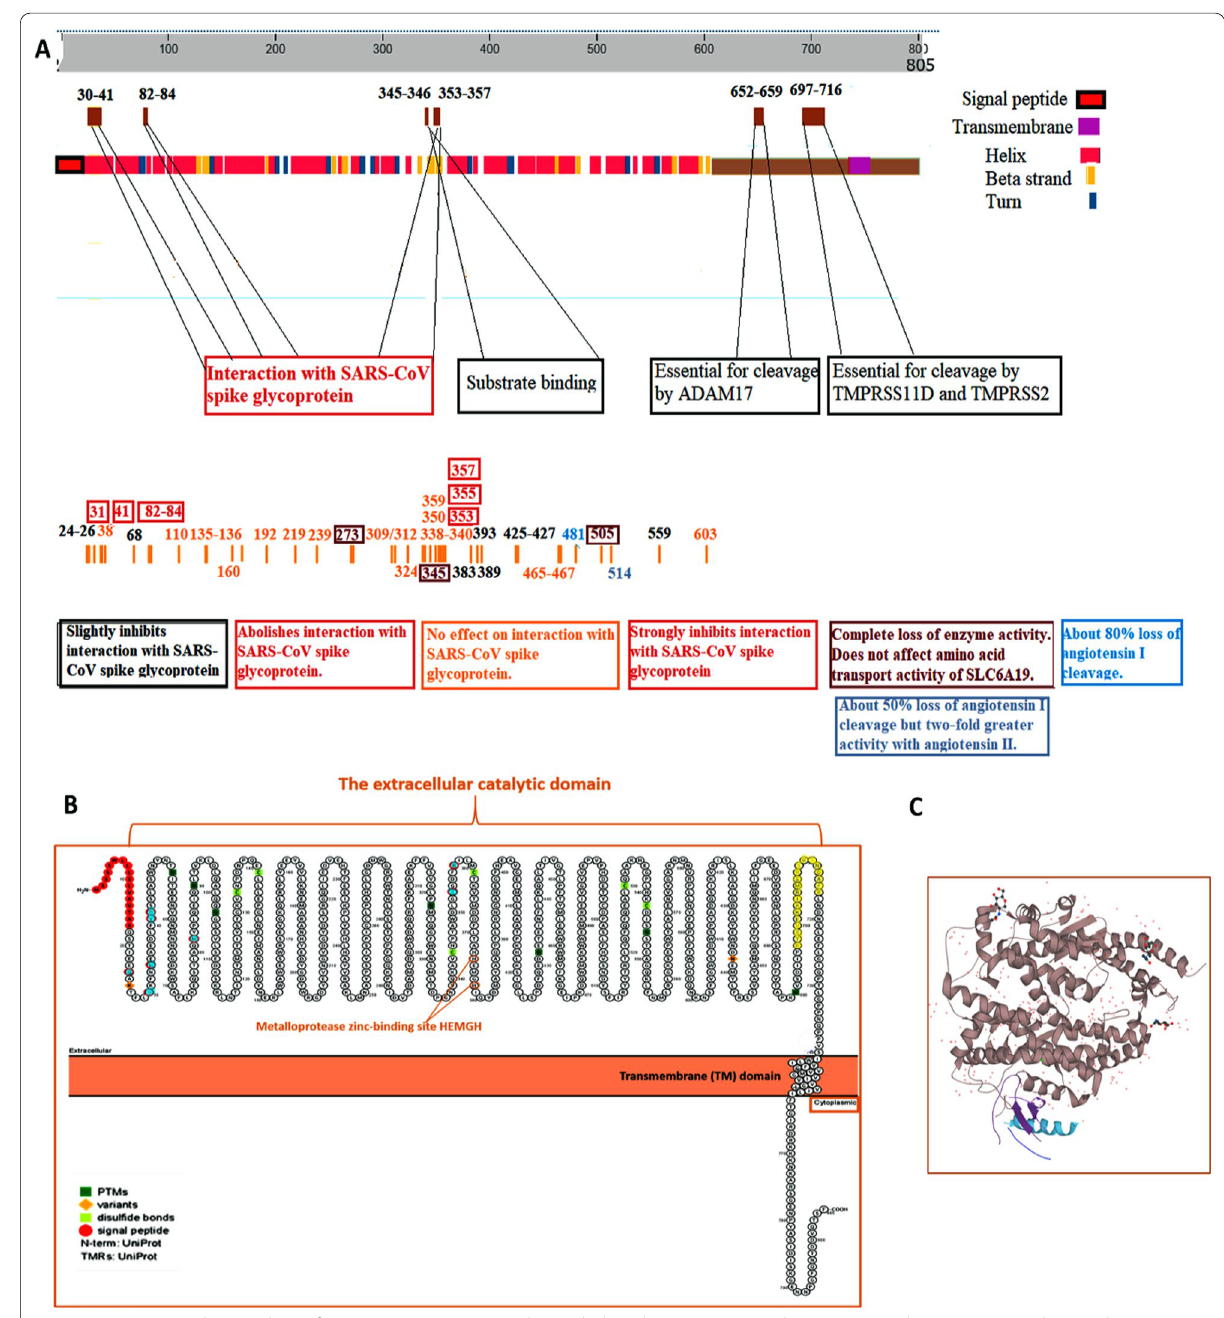
Fig. 3 Sequence and aa residues of ACE2. A ACE2 gene encoding a deduced 805-aa protein. The unprocessed ACE2 (1–17) and ACE2 chain (18–805). Functional roles are illustrated based on [34] and [35]. (https:// www. unipr ot. org/ unipr ot/ Q9BYF1/ protv ista). B ACE2 sequence contains an N-terminal signal (1 to 18), a TM domain (740 to 763), and a metalloprotease zinc-binding consensus (374 to 378, HEMGH). Blue aa residues are required for RBD interaction with the extracellular catalytic domain of ACE2 [36]. C. 3D structure of the ACE2 protein (https:// www. unipr ot. org/ unipr ot/ Q9BYF1/ protv